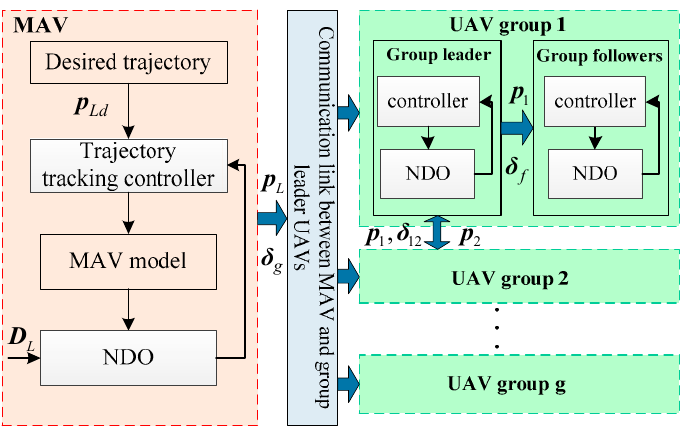
Figure 2. MAV/UAV group formation control structure.